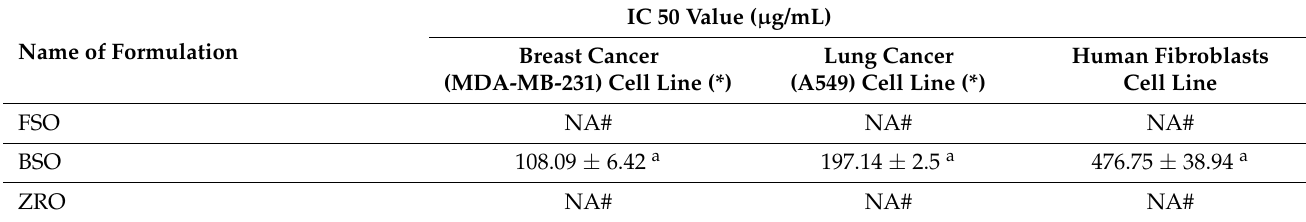
Table 8. IC 50 value of different formulations on breast, lung cancer and human fibroblasts cell